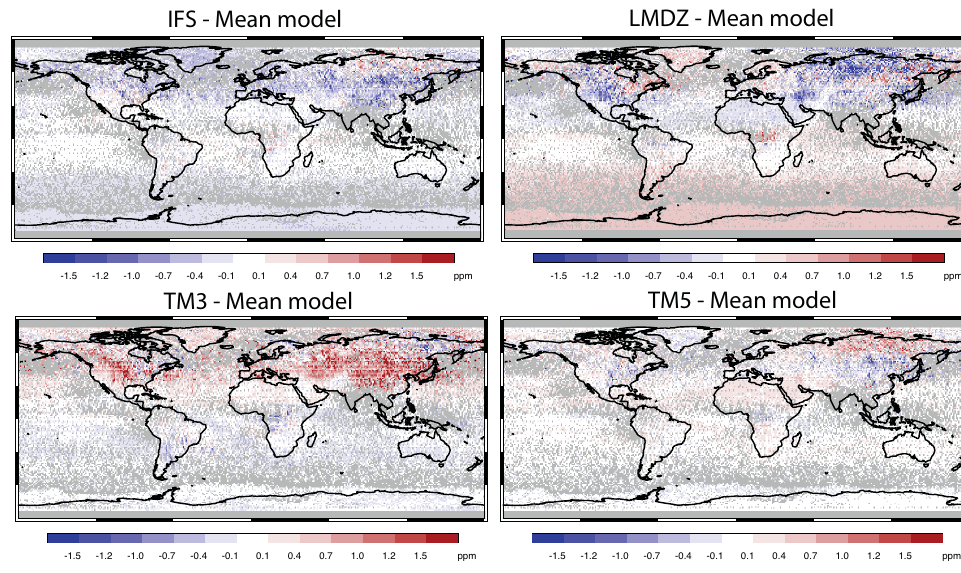
Fig. 4. The difference in x CO 2 between each model and the mean model for July 2005, using A-SCOPE